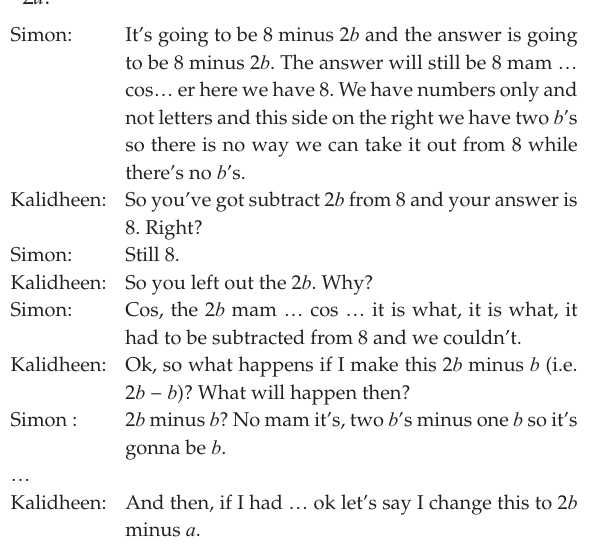
TABLE 3: Percentage of errors showing focus on numbers.